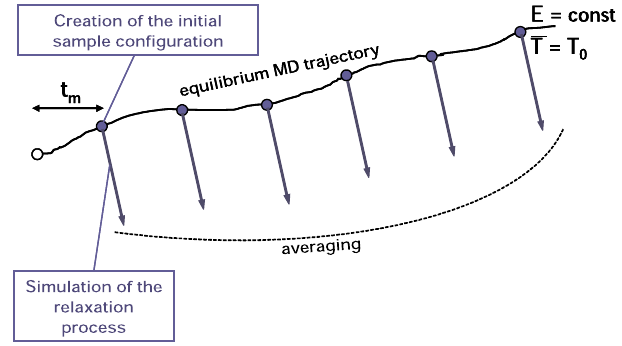
FIG. 3. General simulation scheme: averaging over an en- semble of initial states taken from an auxiliary equilibrium trajectory (solid curve with points).